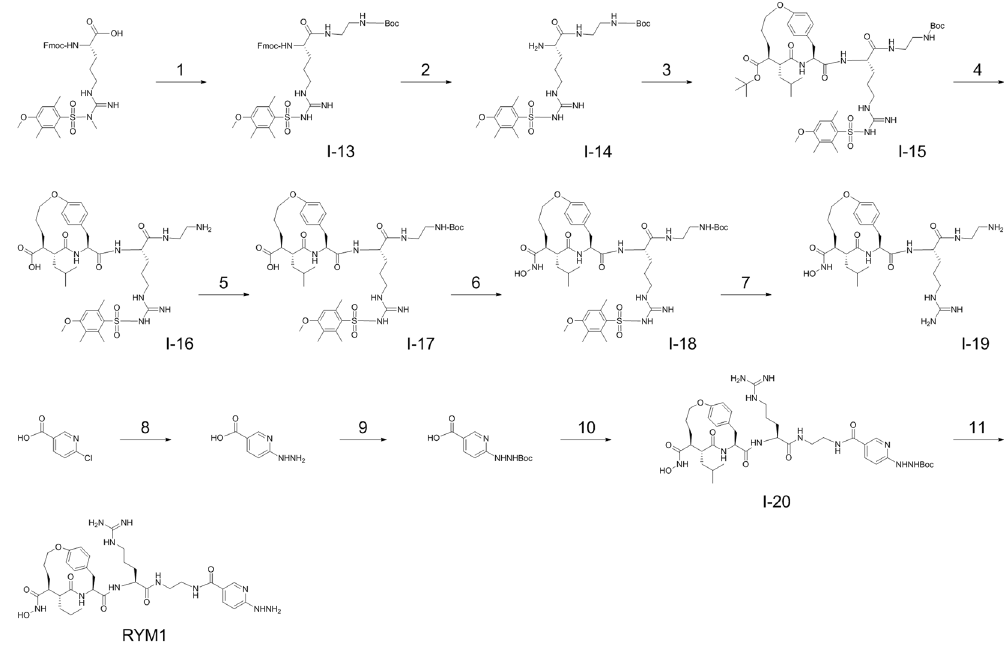
Figure 5. Synthesis of an Arg-containing macrocyclic hydroxamate HYNIC conjugate, RYM1.